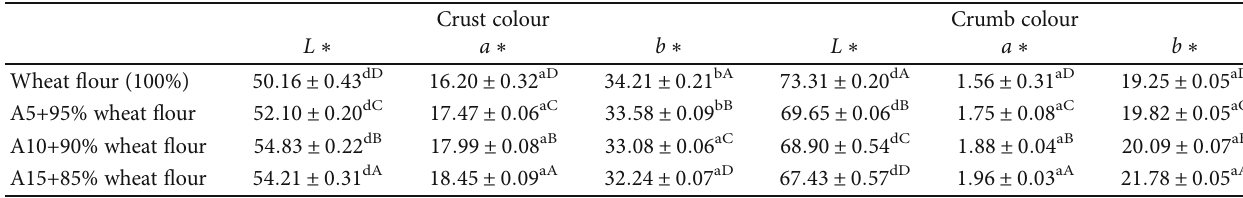
Table 9: E ff ect of substitution of amaranth fl our on colour of bread. Crust colour Crumb colour L ∗ a